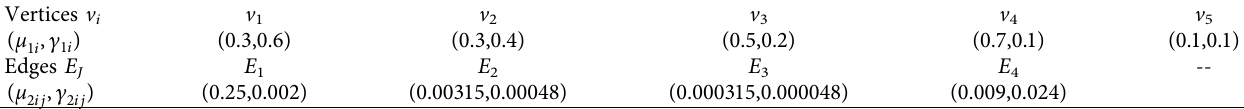
Table 6: Degree of membership and nonmembership values for vertices and edges of Figure 6.